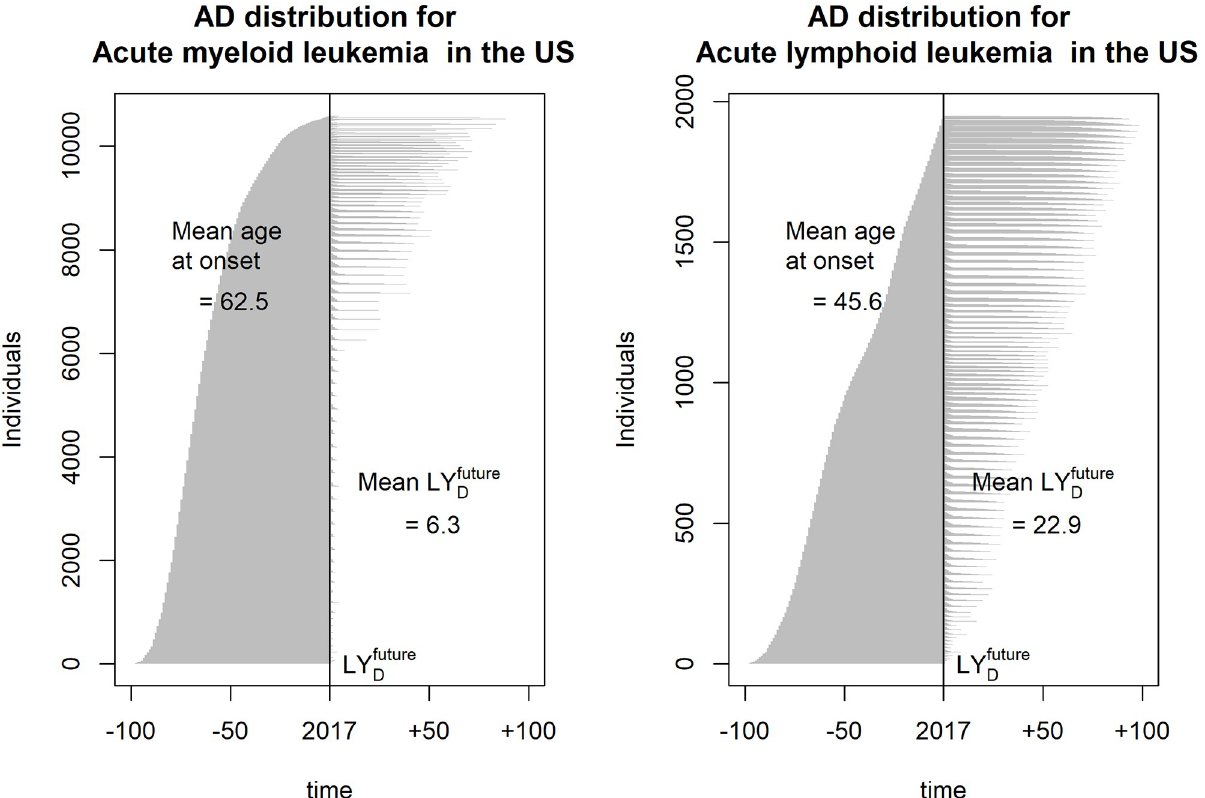
Fig 2. Estimated Age at Death (AD) for individuals who got leukemia in the US in 2017, sorted according to age at onset. Left panel: Distribution for acute myeloid leukemia (AML). Right panel: Distribution for acute lymphoid leukemia (ALL).